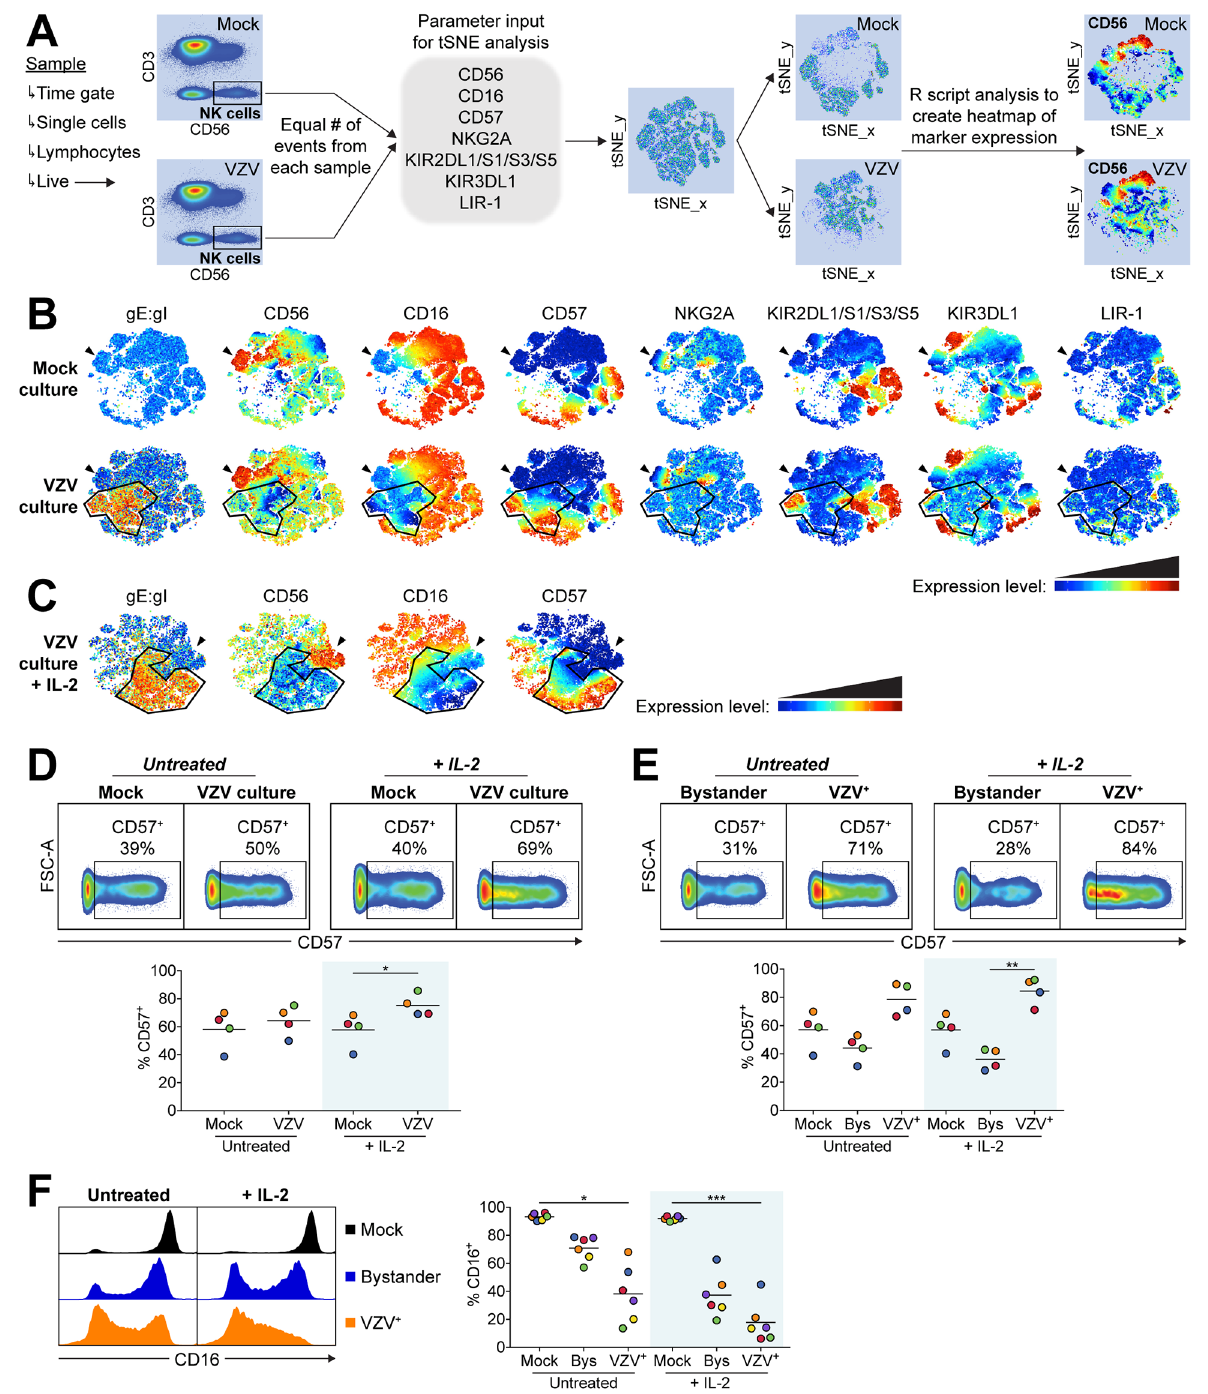
Fig 5. NK cell markers associated with maturity influence VZV infection of NK cells and are modulated by VZV. Healthy human donor PBMCs were mock or VZV infected with or without IL-2 (200 U/ml) for 2 days then analysed by flow cytometry. (A) Diagram describes gating strategy and tSNE analysis workflow for samples shown in (B & C). (B & C) tSNE plots show marker expression levels for single parameters on individual cells in the tSNE map for mock and VZV cultured NK cells after 2 days, either untreated (B) or in the presence of IL-2 (C). Arrowheads indicate the CD56 bright NK cell subset, and the outlined population indicates the localisation of VZV + NK cells. One representative experiment of three is shown. (D & E) Plots show CD57 expression between mock and VZV cultured NK cells (D) and between bystander and VZV + NK cells (E), from one representative donor. Graphs show respective frequencies of CD57 + NK cells when untreated or with IL-2 (shaded) for four donors. Bars indicate